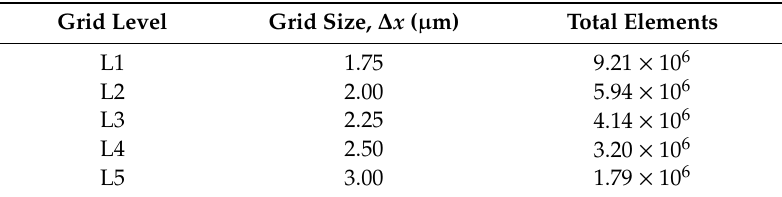
Table 2. Grid properties tested in grid